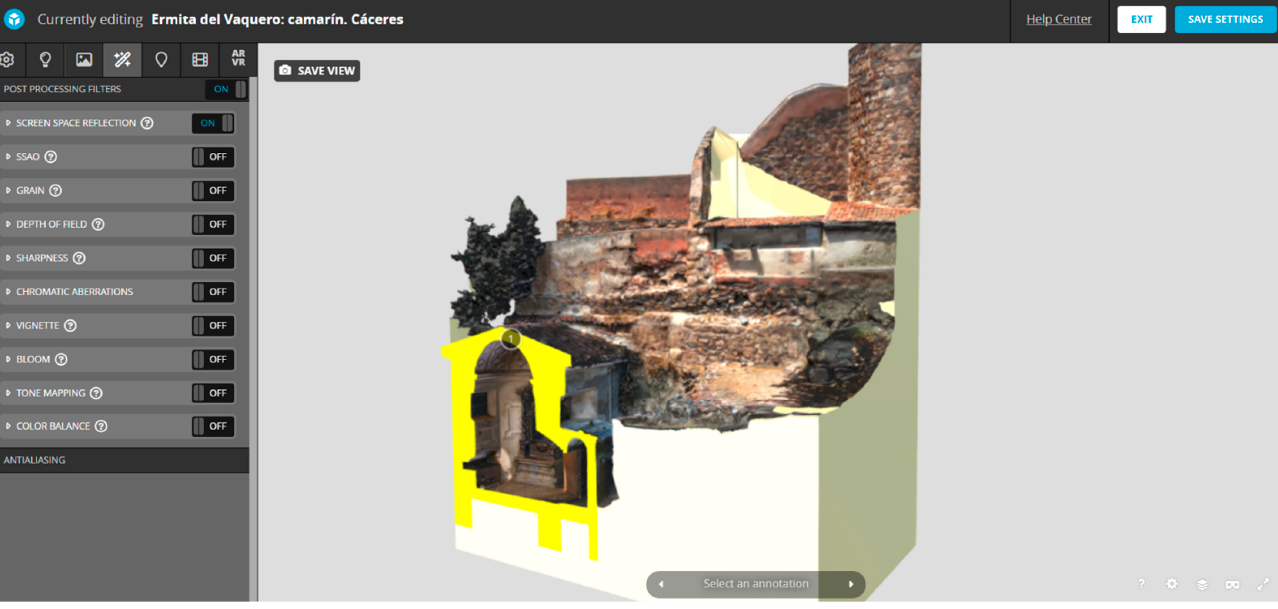
Figure 19. Sketchfab interface. Postprocessing filters.